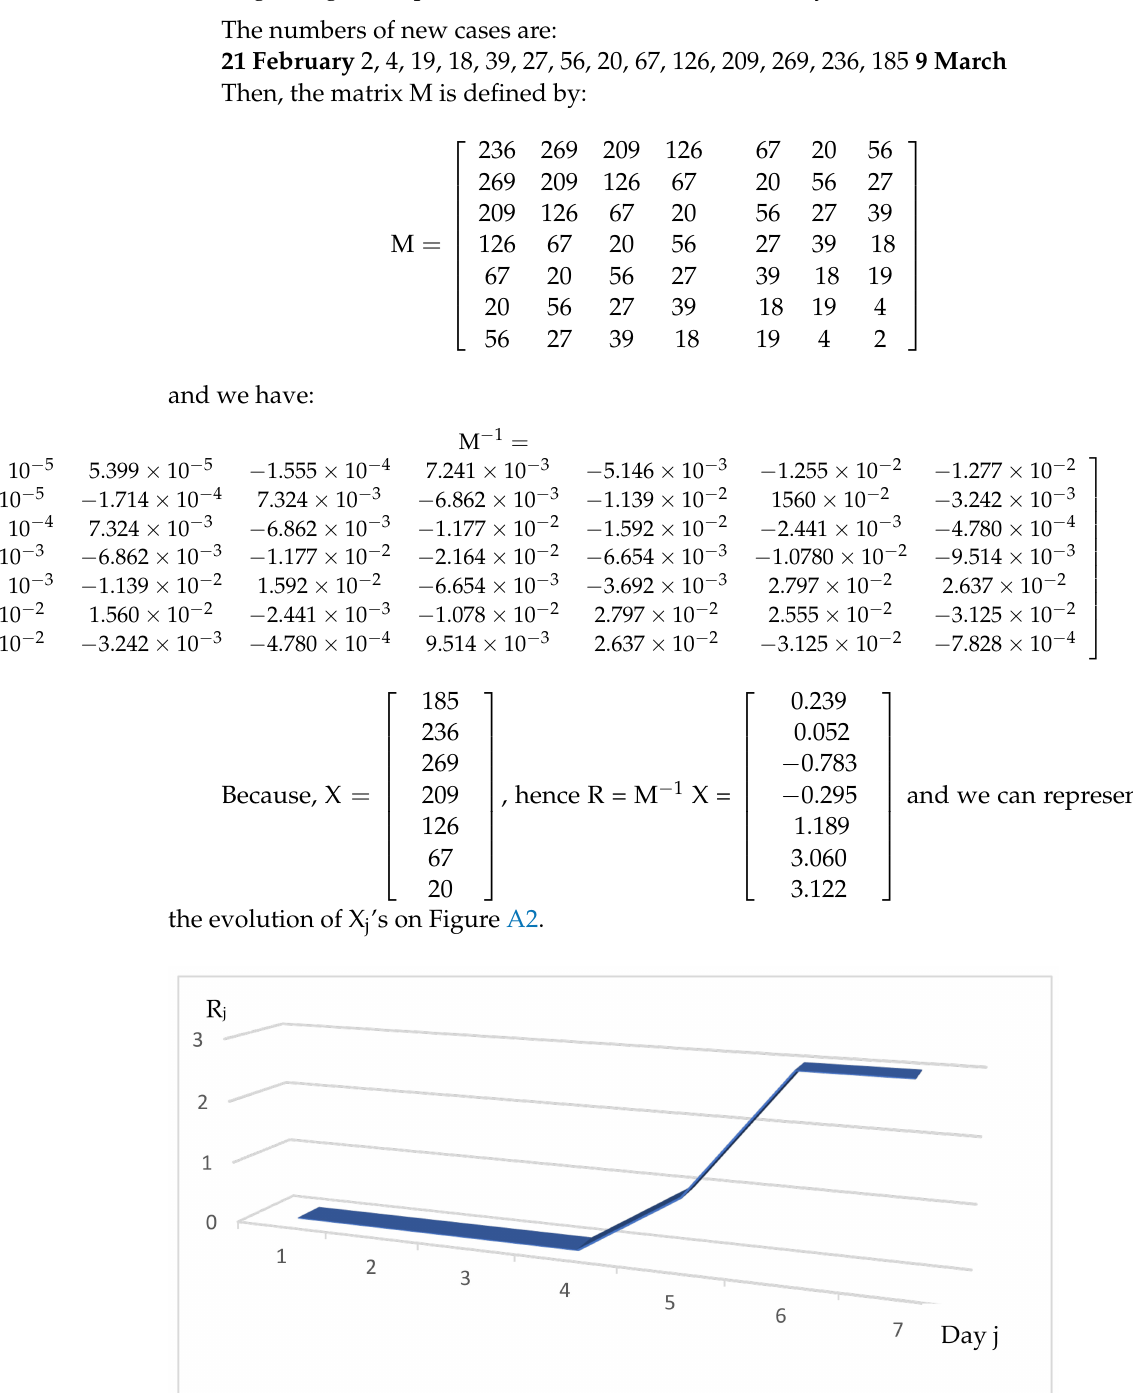
Figure A2. Values of the daily reproduction numbers R j along the period of contagiousness of length 7 days. The evolution of the Xj’s along the period of contagiousness shows at day 4 a sharp increase and a